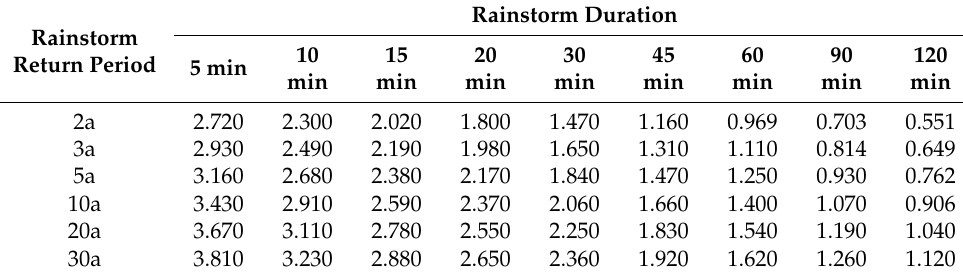
Table 4. The relation of intensity–duration–frequency for RF period (units: mm/min).